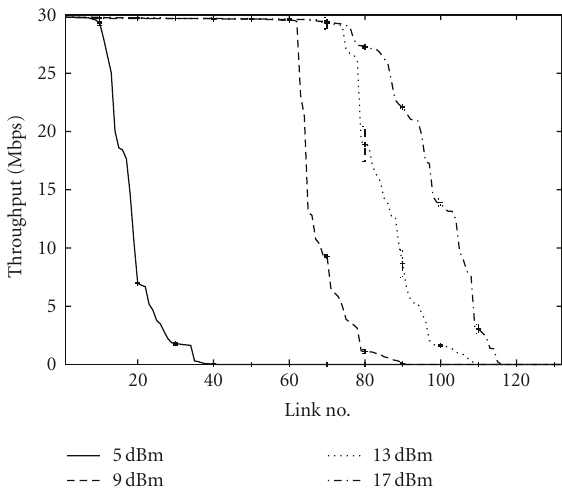
Figure 8: Impact of the transmission power on the connectivity of the 802.11a testbed.